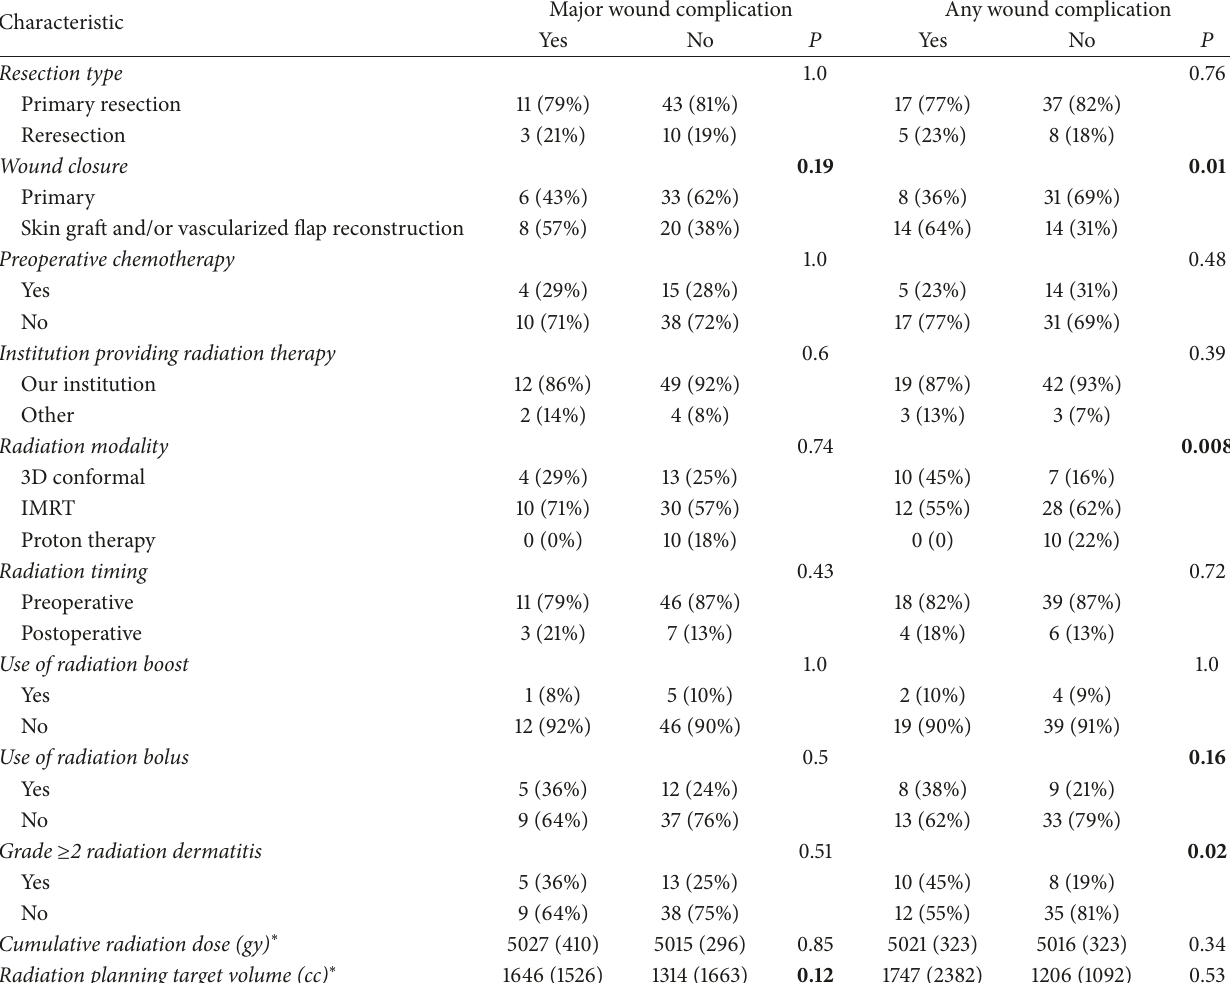
Table 2: Treatment characteristics.